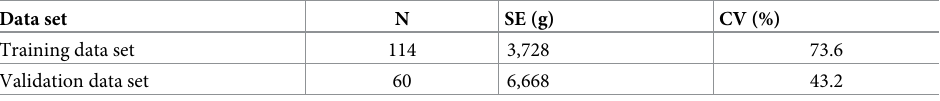
Table 4. Performance of model 11, back-transformed to its power-law form ( y = (409.047 (cid:1) v 0.976 ) (cid:1) 1.17), using the training data set (present study) and an independent validation set from Delitti et al. [17].